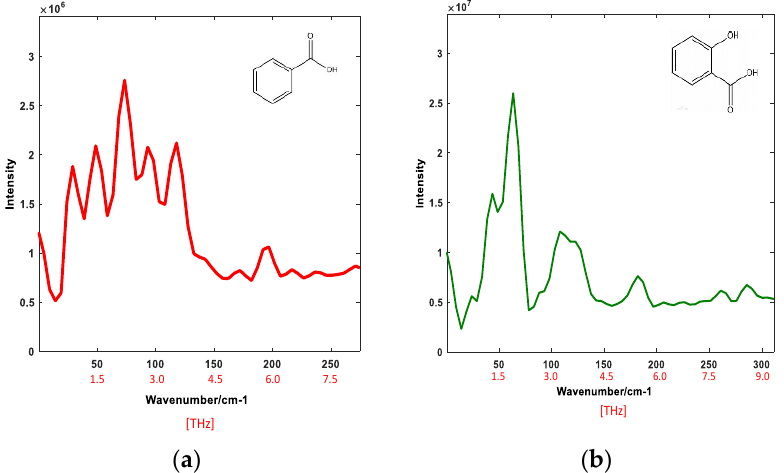
Figure 5. ( a ) THz Raman spectra of BA at a laser power of 50 mW with an integration time of 50 s. ( b ) THz Raman spectra of 2-hydroxy BA at a laser power of 50 mW with an integration time of 50 s. Salicylic acid (2-hydroxy BA) is a white crystalline powder that is similar to BA in